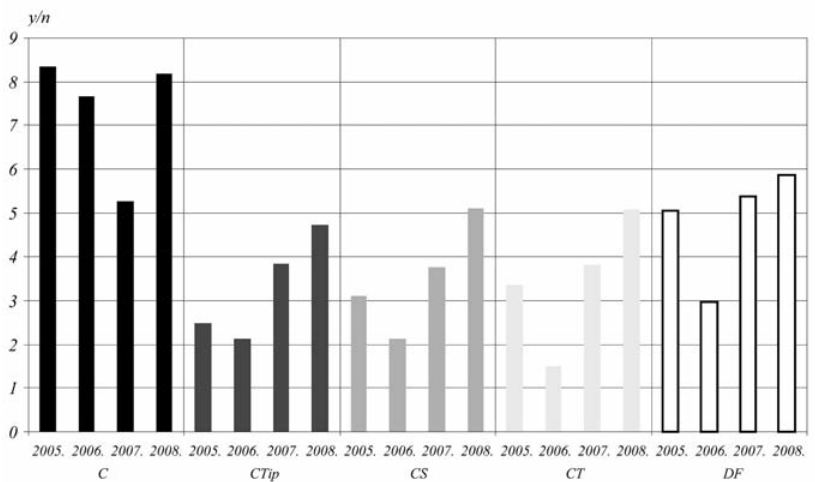
Figure 1. Effect of the treatments on the Ravaz index (y/n) from cv. Kékfrankos, 2005-2008. (C – control, CTip – cluster tipping, CS – cluster shredding, CT – cluster thinning, DF – defoliation at the